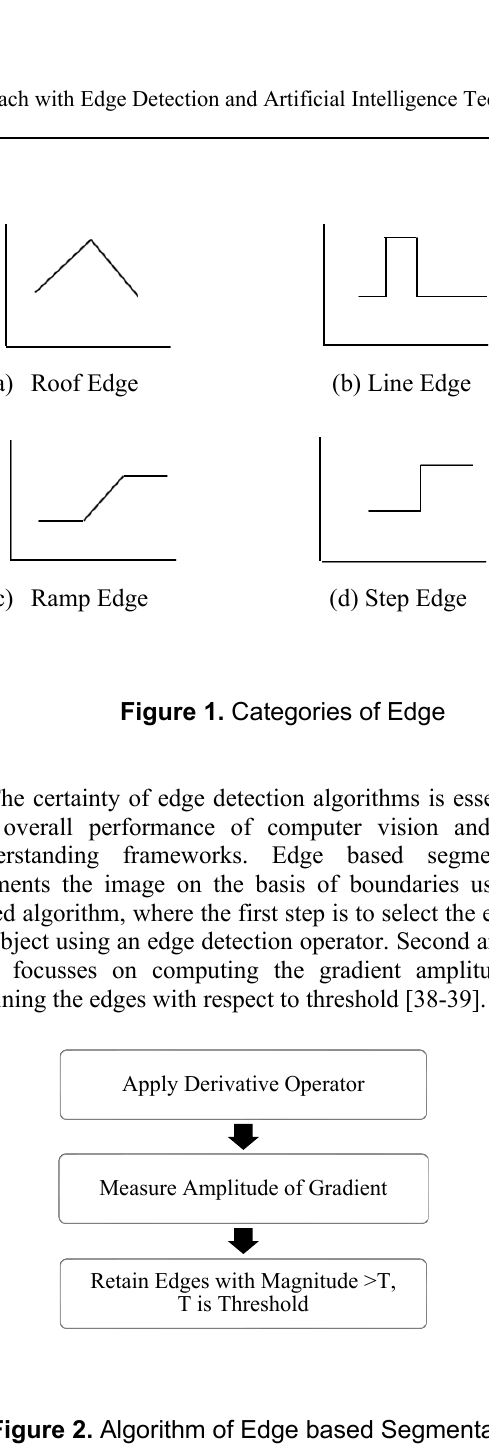
Figure 2. Algorithm of Edge based Segmentation